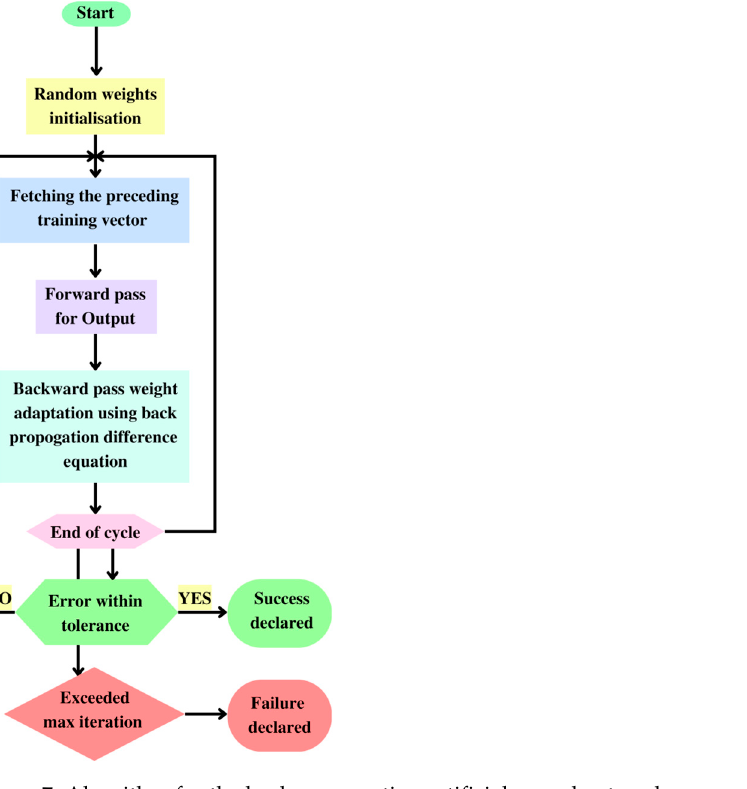
Figure 6. Structure of Back Propagation Artificial Neural Network used in the study.